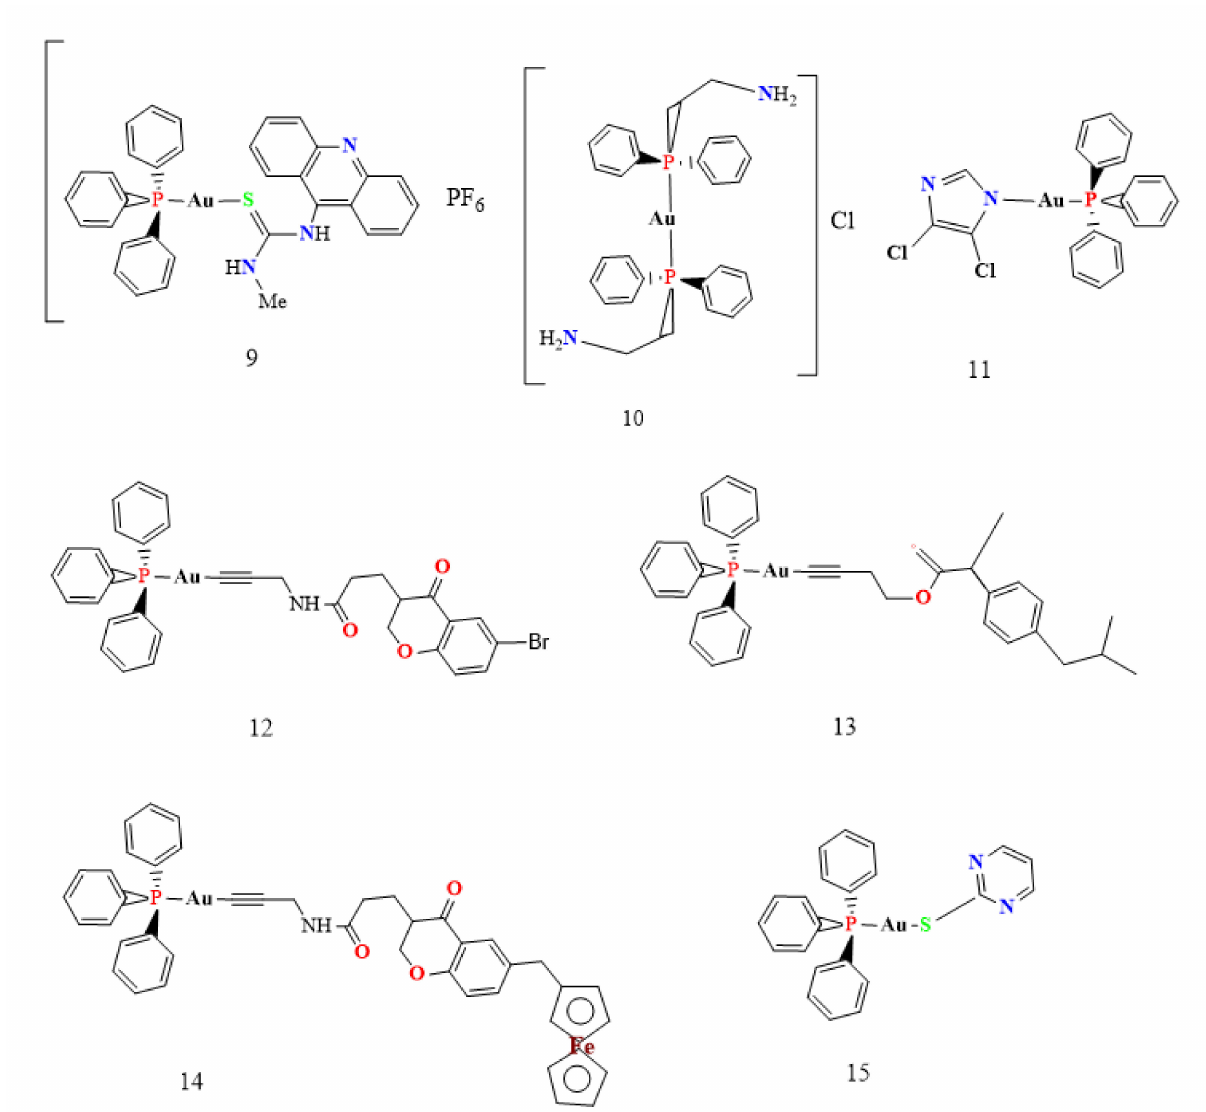
Scheme 2. Representative structures of selected gold(I) phosphane compounds labeled as the entries of Table